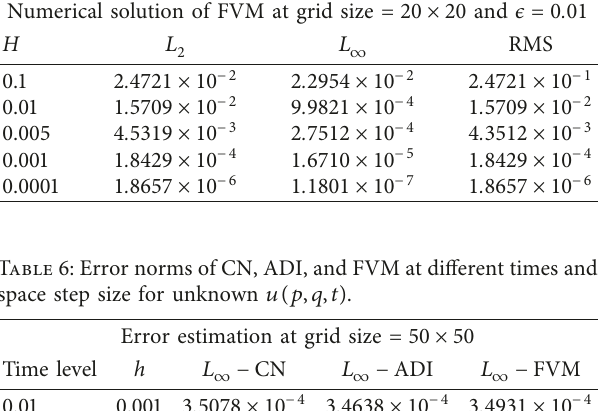
Table 5: Error norm of finite volume at different step sizes for unknown u ( p,q,t ) .